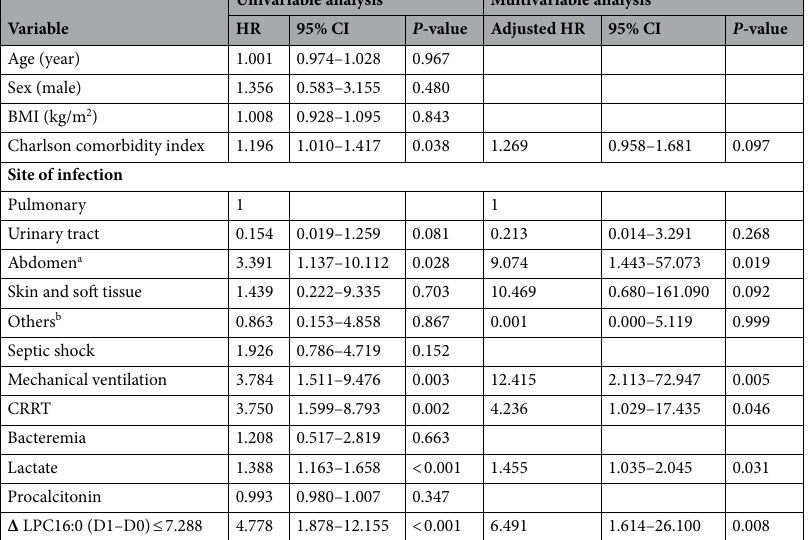
Table 2. Cox proportional hazard model of 28-day mortality. HR hazard ratio, CI confidence interval, BMI body mass index, CRRT continuous renal replacement therapy, SOFA Sequential Organ Failure Assessment, APACHE Acute Physiology and Chronic Health Evaluation. a Abdomen: gastrointestinal, hepatobiliary infection, peritonitis. b Others: meningitis, spinal abscess, septic arthritis, primary unknown infection.